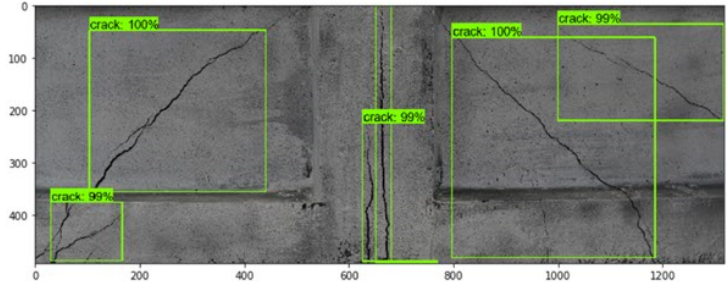
Figure 15. Detected and localized surface cracks (green rectangles) in the testing image of concrete beam using trained Faster R-CNN